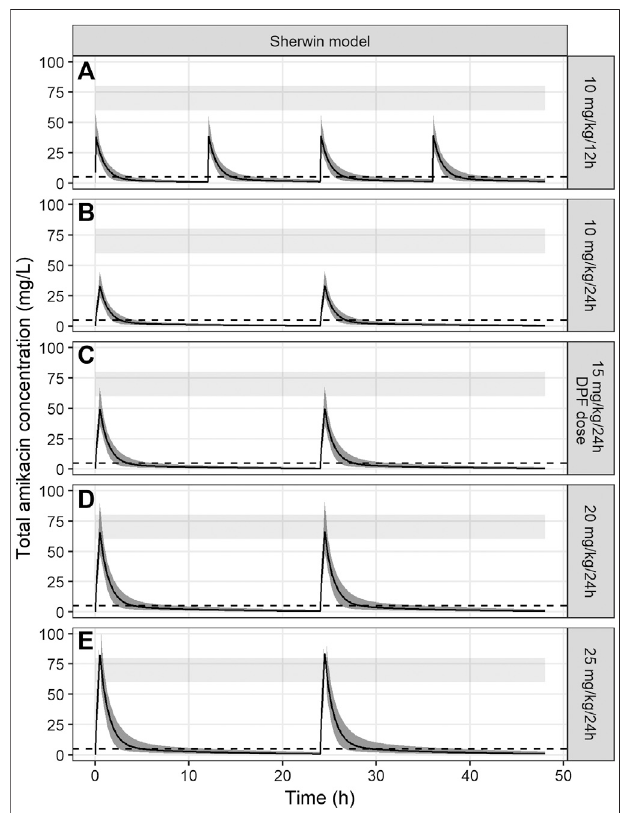
FIGURE 3 | Amikacin concentration-time curves simulated over 48 h using the PK model of Sherwin et al. The black line represents the median amikacinconcentration, thedark grey areaaroundthe linethe95% prediction interval. The light grey band represents the target Cmax (60 – 80 mg/L) and the dotted line represents the target Cmin ( < 5 mg/L). Panels (A) – (E) represent different tested dosing regimens, including the currently advised DPF dose (panel (C)